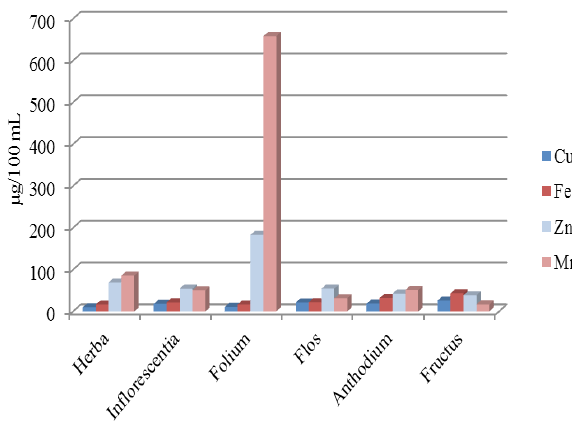
Figure 2: The contents of microelements in herbal